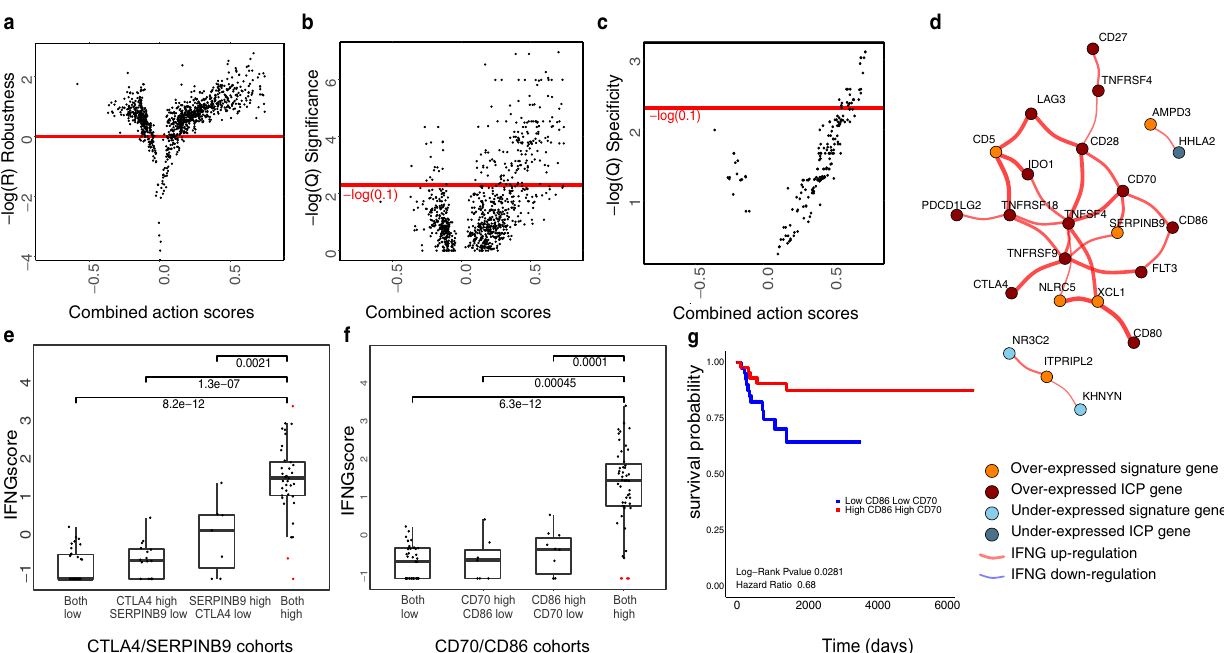
Fig. 2 Interactions of T-cell dysfunction signature genes with immune checkpoints in uterine corpus endometrial carcinoma (UCEC). ImogiMap-based assessment of combinatorial interactions for T-cell dysfunction signature genes in UCEC, and therapeutically actionable ICPs, based on their associations with the IFNG gene expression. The analysis is based on RNA expression data from tumors of 370 patients. a Combined action score robustness. A normalized root mean square deviation (RMSD) is calculated for each combined action score through random sampling (1000x) of sub-cohorts with 70% coverage of the complete cohort. Scores with high robustness, (cid:1) log R ð Þ > 0 (red horizontal line) are selected for further analysis (see “ Methods ” ). b Statistical signi fi cance of combined action scores. An FDR (Benjamini-Hochberg (BH) method) corrected Q -value based on the Wilcoxon signed-rank test is calculated for robust scores. Scores with Q Significance < 0 : 1 are selected for further analysis. c A BH-corrected Q -value for speci fi city is calculated for each robust and signi fi cant interaction (see “ Methods ” ). Scores with Q Specificity < 0 : 1 are selected for further analysis. d The graphical network representing robust, signi fi cant, and speci fi c combinatorial associations with IFN γ levels (represented by IFNG gene expression). Red (Blue) edges represent upregulation (downregulation) of IFNG . Dark red (Dark blue) vertices identify overexpression (low-expression) of ICP genes and orange (blue) vertices identify overexpression (low-expression) of T-cell dysfunction signature genes. e Levels of IFNG gene expression in TCGA UCEC samples, strati fi ed based on SERPINB9 and CTLA4 levels. p values from Wilcoxon signed-rank test indicate the statistical signi fi cance of differences in IFN γ levels within the strati fi ed sub-cohorts. f Levels of IFNG gene expression in TCGA UCEC samples, strati fi ed based on CD86 and CD70 levels. g Kaplan – Meier survival curve for UCEC patients strati fi ed by low/high expression of CD70 and